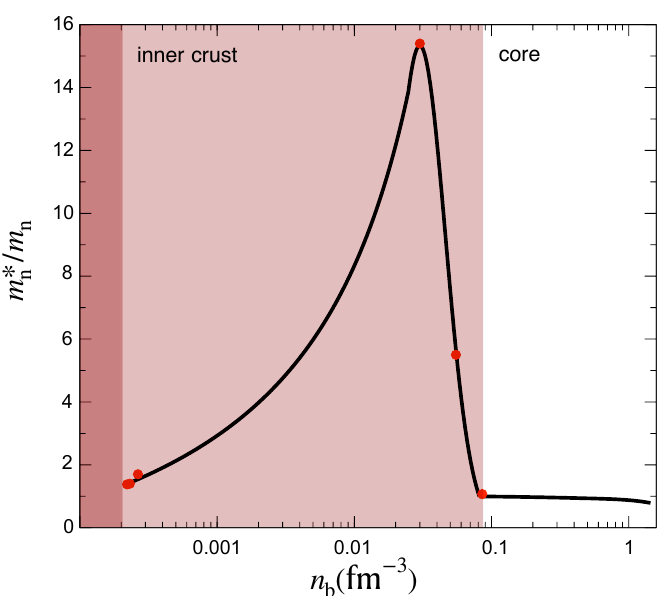
Figure 2. An indication of the dependence of the effective neutron mass—encoding the superfluid entrainment—on the baryon number density, n b . In the crust, the curve has been fitted to the data points from Chamel and collaborators [50–52] (shown as filled circles). The results in the core are obtained by assuming that the dynamical effective mass is equal to the Landau effective mass from nuclear physics (which should be a good approximation as the proton fraction is